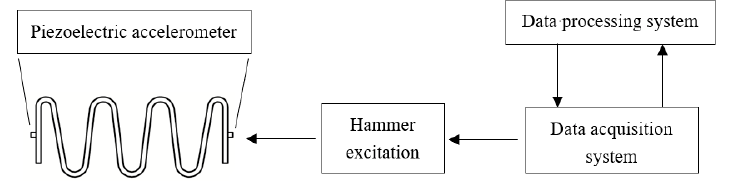
Figure 8. Frequency response characteristic experiment process block diagram.